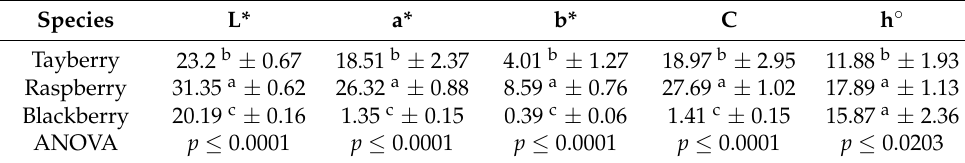
Table 3. Chromatic parameters of fresh berry